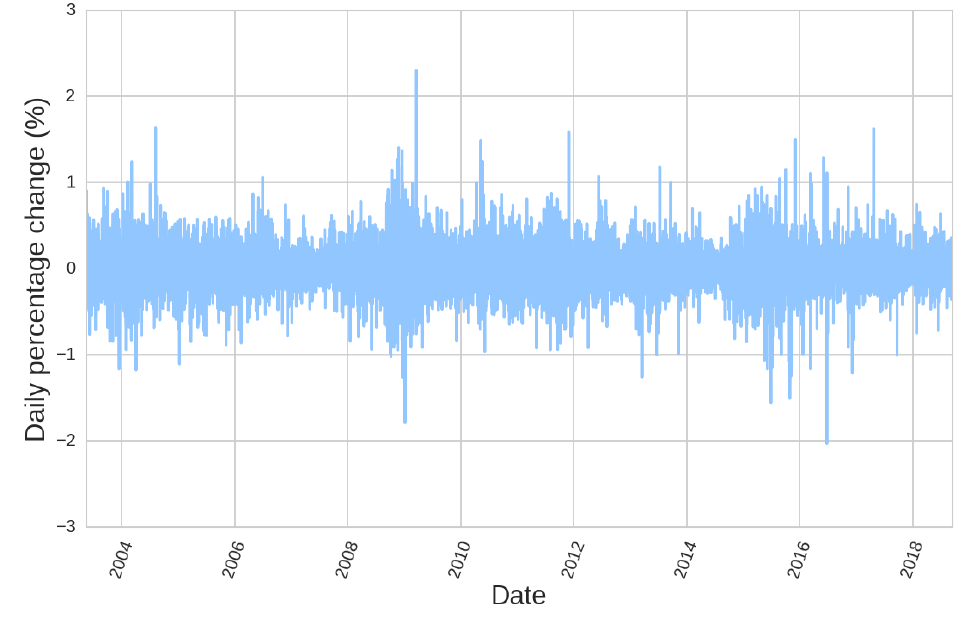
Figure 1. Volatility clustering can be appreciated in EURUSD price